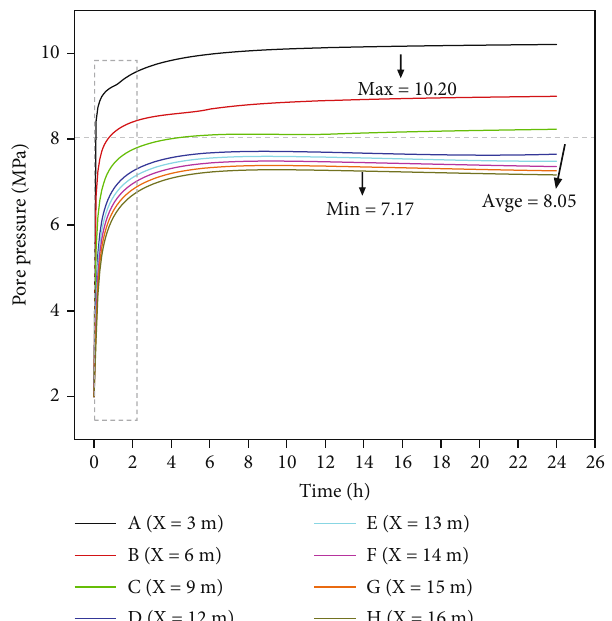
Figure 5: Time-dependent pore pressures at each detection point. Min: Minimum pore pressure in all detection points at the end of displacement.